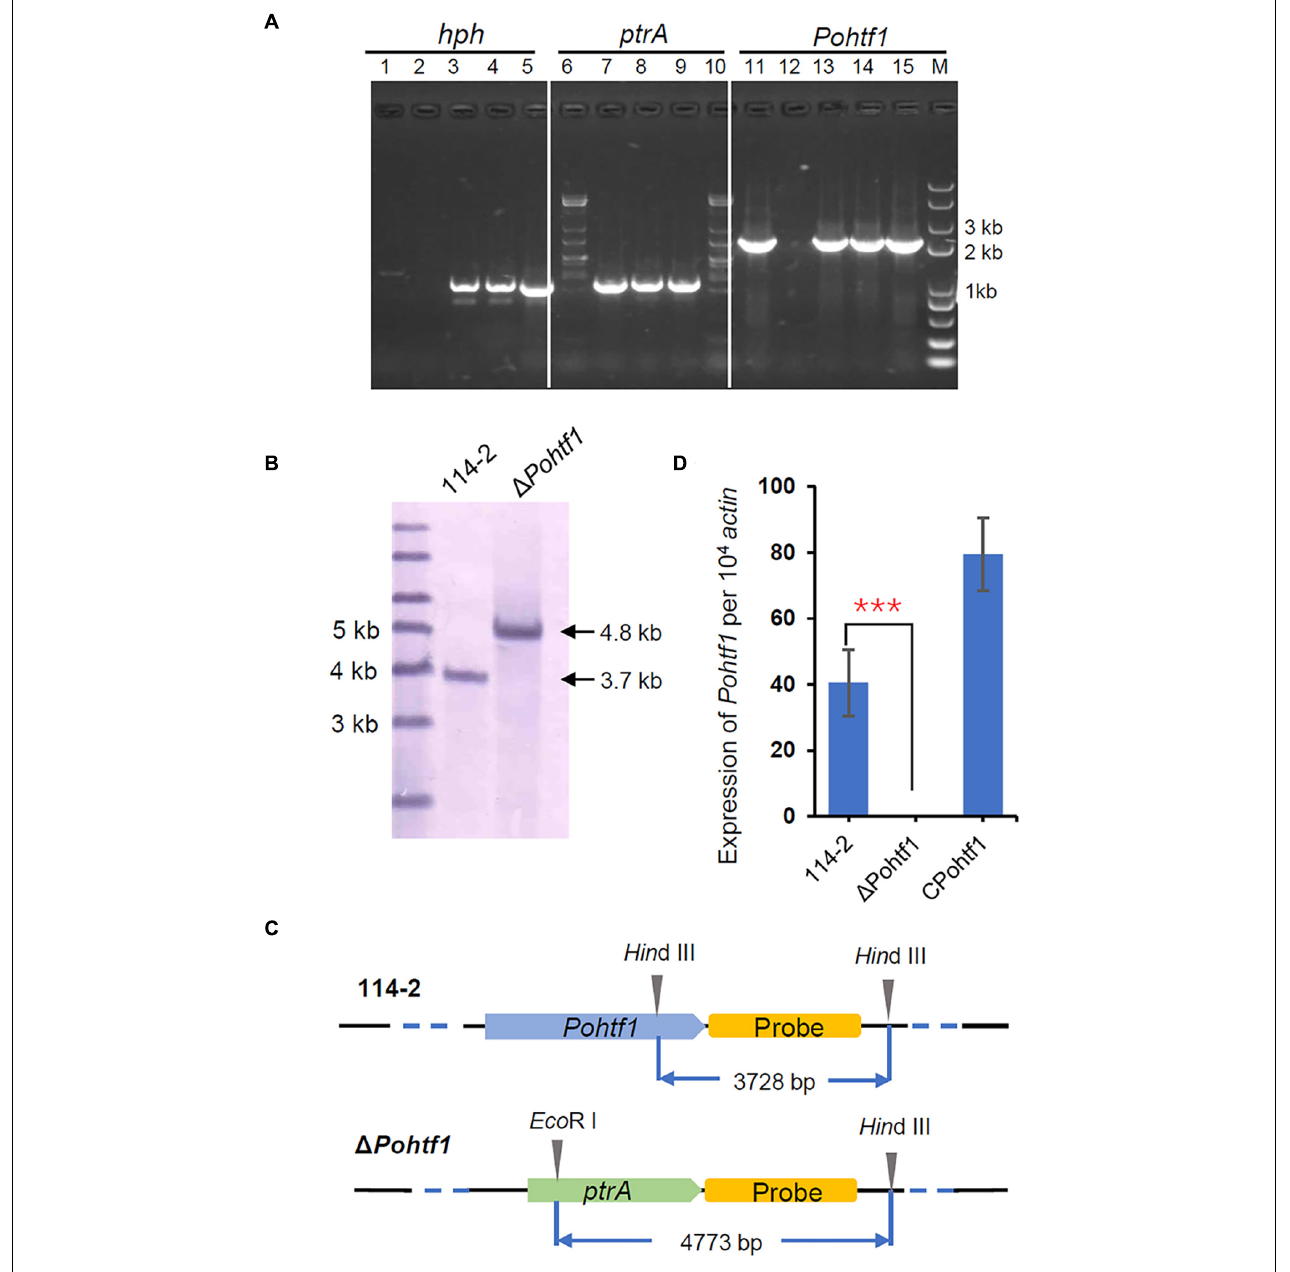
FIGURE 2 | Deletion and verification of Po Htf1. (A) PCR analysis of Pohtf1 deletion and complement. The confirmation of Pohtf1 deletion and complement was performed using three pairs of primers: primers inside the selected marker genes hph (hph-YZ-F/R) (lane 1–5) and ptrA (ptrA-YZ-F/R) (lane 6–10) and primers amplifying the target gene Pohtf1 (7199-hphF/7199-hphR) (lane 11–15). Primer sequences are listed in Supplementary Table 1 . Lane 1, 6, 11 are the results of the WT strain P. oxalicum 114-2. Lane 2, 7, 12 are the results of Pohtf1 -deletion strain. Lane 3–4, 8–9, and 13–14 are the results of two Pohtf1 -complement strains. (B) Southern blot analysis of (cid:49) Pohtf1 . After deletion of Pohtf1 , a 4.8 kb-length fragment was hybridized in the (cid:49) Pohtf1 genome by Southern blot, while the fragment length in P. oxalicum 114-2 was 3.7 kb. (C) Southern blot strategy. A 2 kb-length fragment downstream of the target gene was amplified as the hybridization probe. P. oxalicum 114-2 genomic DNA was digested by a single restriction endonuclease, Hin dIII, and a 3.7 kb-length fragment containing the complete probe sequence was generated. The (cid:49) Pohtf1 genomic DNA was double digested with Hin dIII and Eco RI to generate a 4.8 kb-length fragment. (D) qRT-PCR analysis of Pohtf1 expression levels in the mutant strains. Pohtf1 expression levels in P. oxalicum 114-2, (cid:49) Pohtf1 , and C Pohtf1 were tested using primers RT-7199-F/R inside Pohtf1 ( Supplementary Table 2 ).